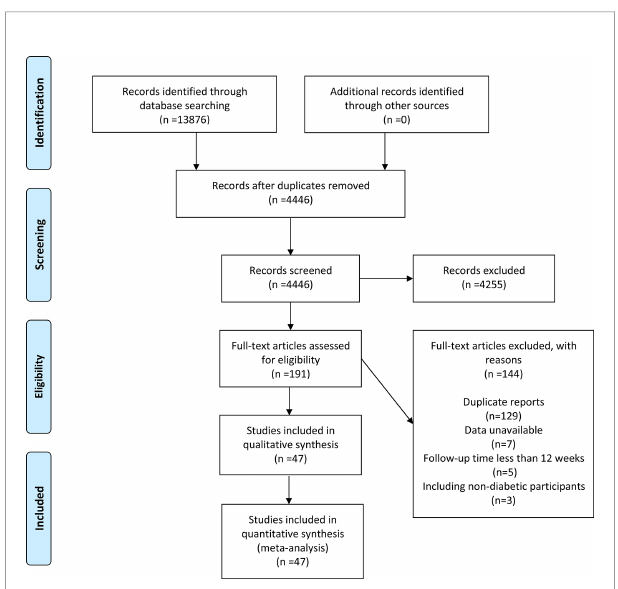
FIGURE 1 | A schematic fl ow for selecting the articles included in this meta-